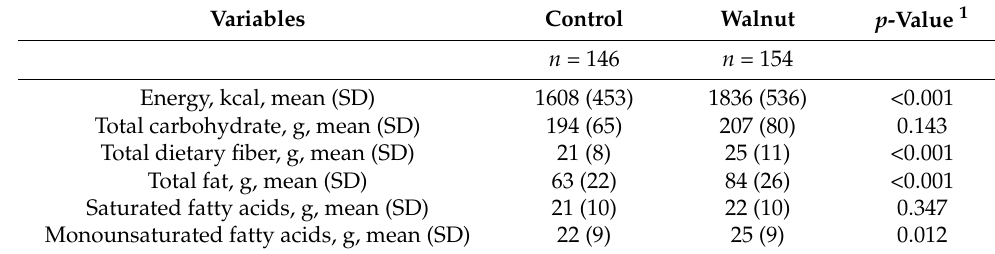
Table 2. Dietary intake of macronutrients per day by treatment